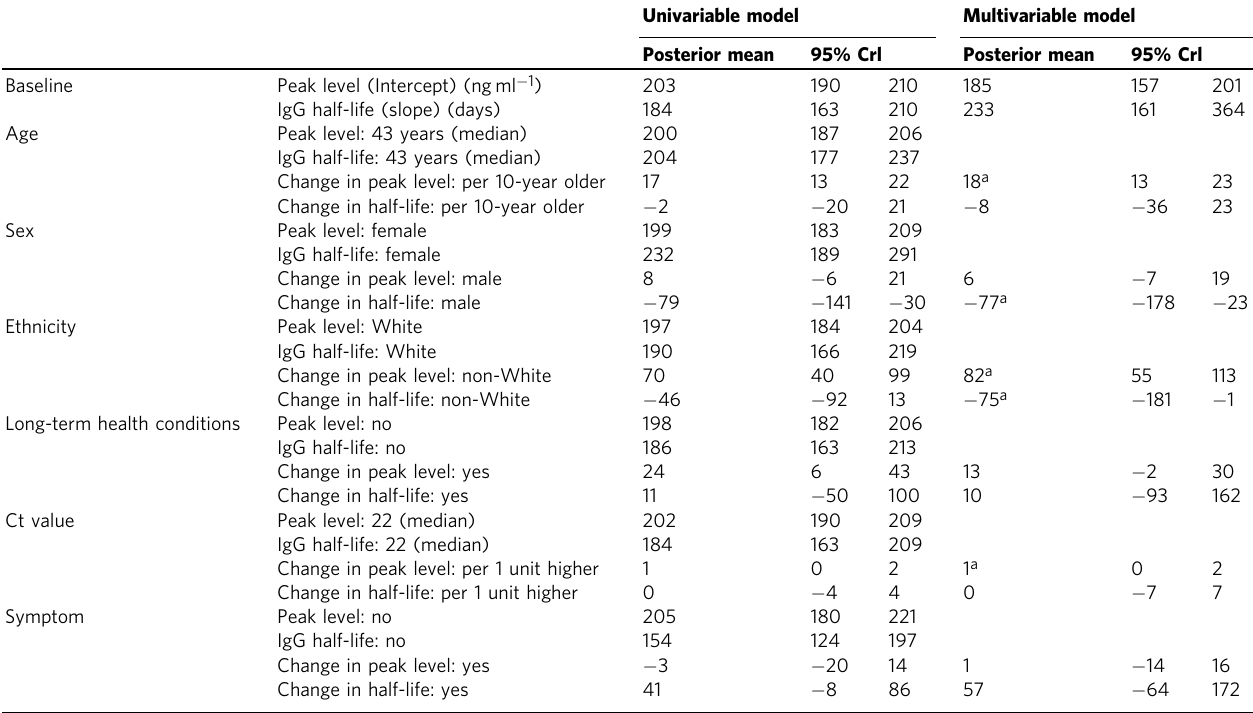
Table 2 Posterior mean and 95% credibility intervals for anti-spike IgG peak level (intercept) (ng ml − 1 ) and half-life (slope) (days) in the univariable and multivariable models in 3271 participants in Class